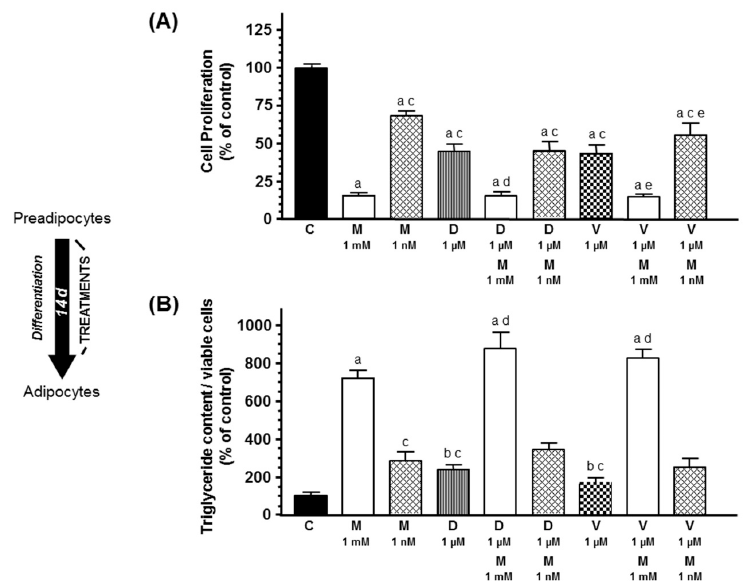
Figure 1. E ff ects of melatonin 1 mM or 1 nM on docetaxel- and vinorelbine-induced changes on ( A ) cell proliferation and ( B ) intracytoplasmic triglyceride content, during the course of di ff erentiation of human breast adipocytes. Cell proliferation was quantified by the MTT method and triglyceride accumulation using the Oil Red O staining method. Data are expressed as the percentage of the control group (mean ± standard error of the mean (SEM)). a, p < 0.001 vs. C; b, p < 0.05 vs. C; c, p < 0.001 vs. M (1 mM); d, p < 0.001 vs. D (1 µM); e, p < 0.001 vs. V (1 µM). C: control, M: melatonin, D: docetaxel, V: vinorelbine.